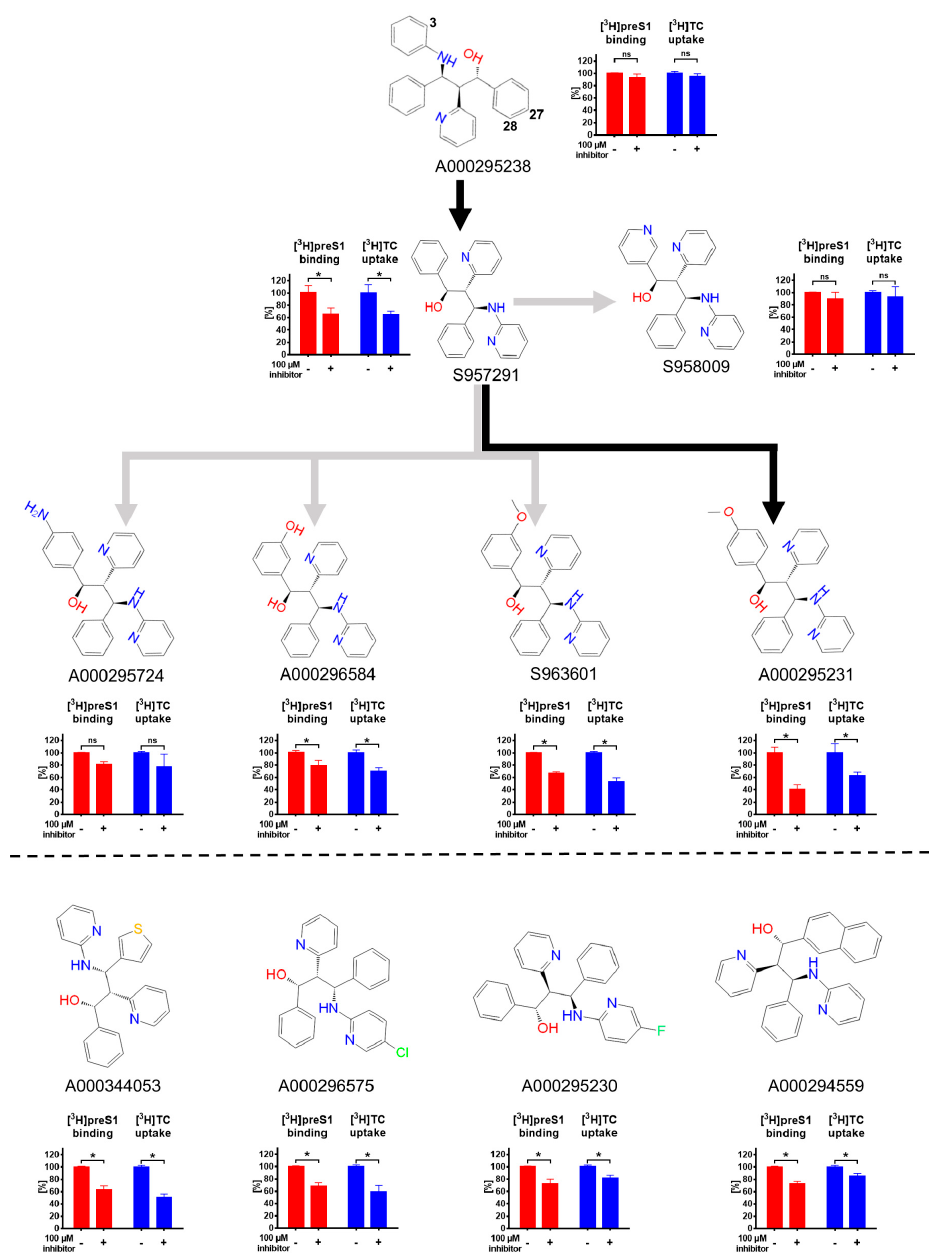
Figure 6. Structure-activity relationships of propanolamine derivatives for [ 3 H]TC transport inhibition and [ 3 H]preS1 bind- ing inhibition. The respective inhibition pattern are illustrated by bar graphs for [ 3 H]TC uptake (shown in blue) and [ 3 H]preS1 peptide binding (shown in red) in the presence (+) or absence ( − ) of a 100 μ M inhibitor concentration of the respective propanolamine derivative. Graphs show means ± SD of triplicate determinations. * Significantly different with p < 0.01 (two-way ANOVA with Sidak’s multiple comparison test); ns, not significant. Chemical modifications and isomeriza- tion of the propanolamine derivatives revealed clear structure-activity relationships for more potent [ 3 H]preS1 lipopeptide binding inhibition (A000295231>S957291>A000295238). Several propanolamine derivatives showed significant but less potent [ 3 H]preS1 lipopeptide binding inhibition. Four representative compounds (A000344053, A000296575, A000295230, A000294559) are